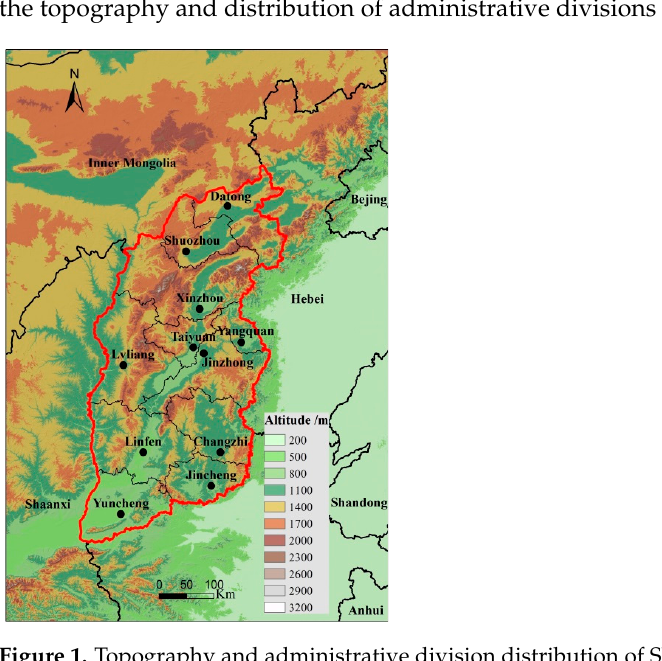
Figure 1. Topography and administrative division distribution of Shanxi Province, China.